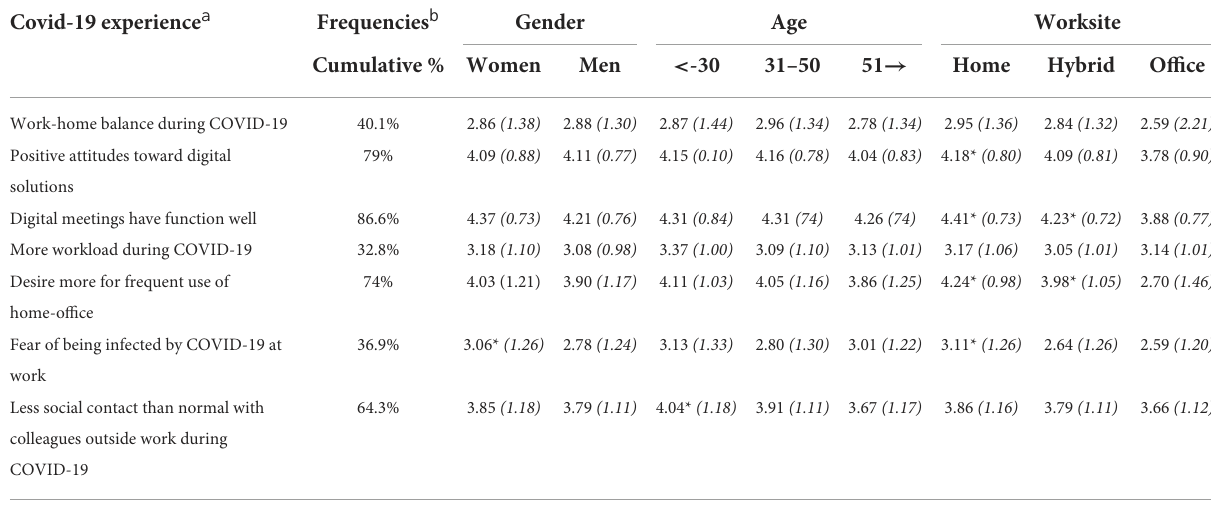
TABLE 4 Frequencies, means, standard deviations (in italics), and results of the univariate GLM of COVID-19 experiences comparing gender, age, and worksite (home office, hybrid, and workplace).